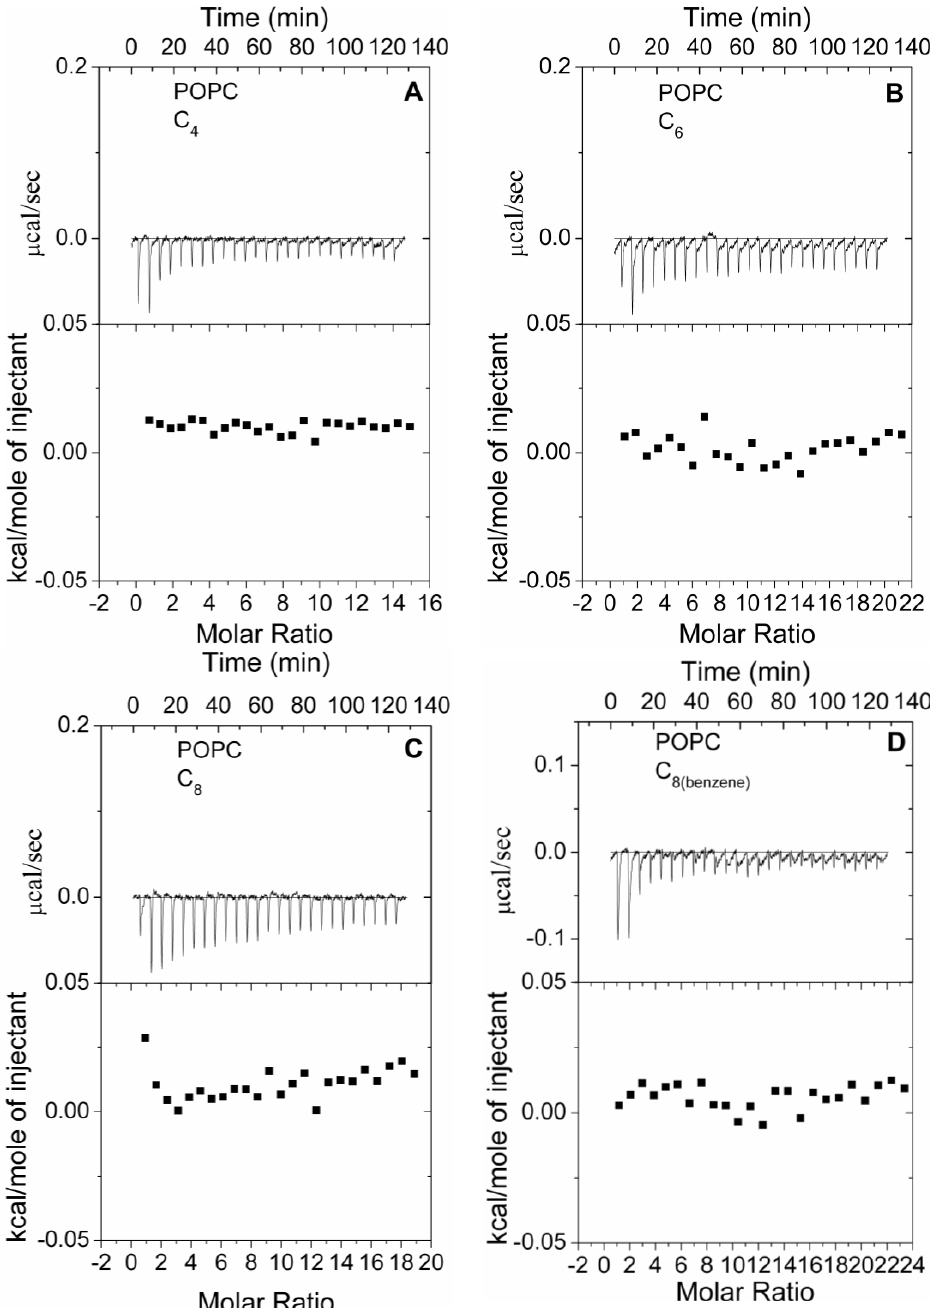
Figure 5. Titration calorimetry of POPC vesicles into Polymer C 4 , C 6 , C 8 , C 8(benzene) solutions at 30 °C. ( A ) Polymer C 4 ; ( B ) Polymer C 6 ; ( C ) Polymer C 8 ; ( D ) Polymer C 8(benzene) . Each oligoguanidine polymer solution at a concentration of 75 μg/mL. Large unilamellar vesicle (LUV) suspension (15 mM) was used. The lower curve in each case represents the heat of reaction (measured by peak integration) as a function of the lipid/polymer molar ratio.